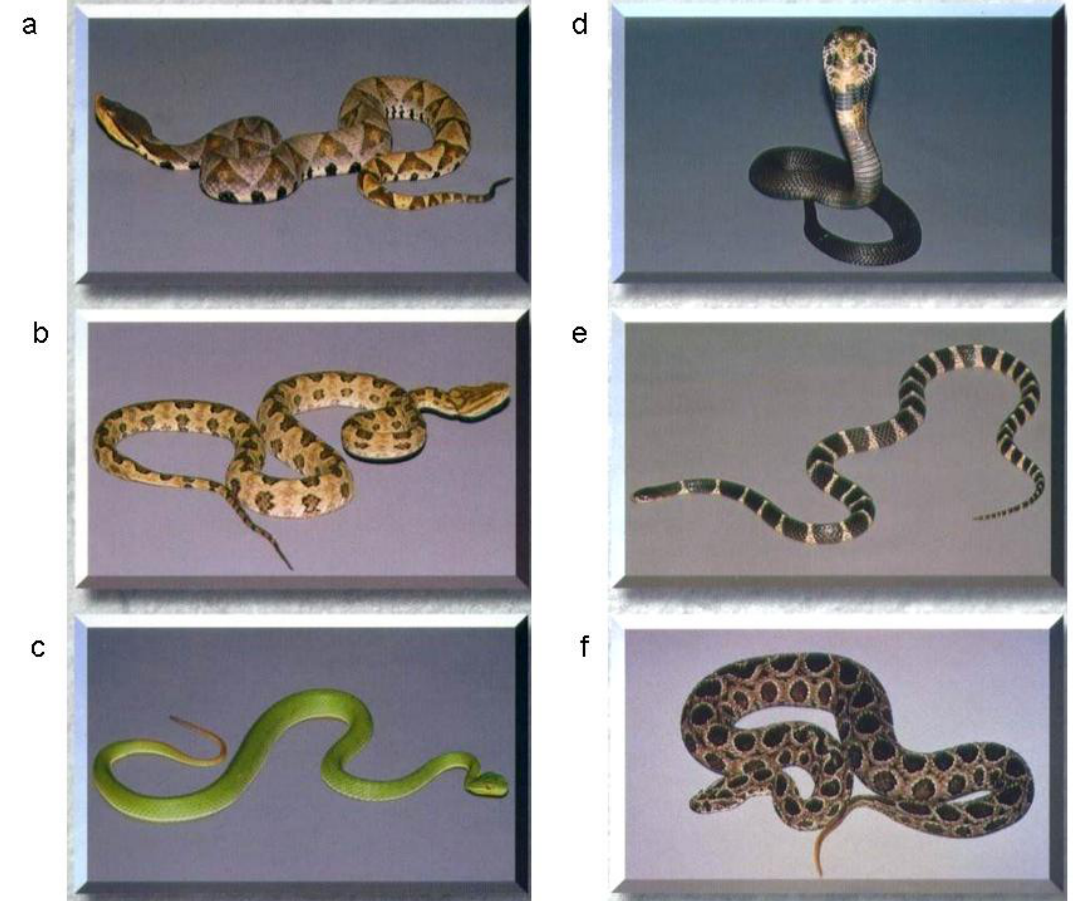
Figure 2. Six most common venomous snakes in Taiwan: ( a ) Deinagkistrodon acutus ; (b) Trimeresurus mucrosquamatus ; ( c ) Trimeresurus stejnegeri ; ( d ) Naja atra ; ( e ) Bungarus multicinctus ; and ( f ) Daboia russelii siamensis (photos by the Foundation for Poison Control of